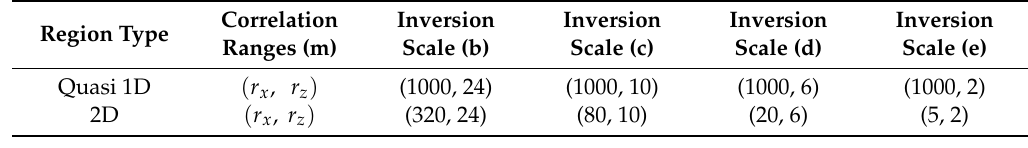
Table 2. Horizontal and vertical correlation ranges for the different a priori region types and inversion scales. Correlation Region Type